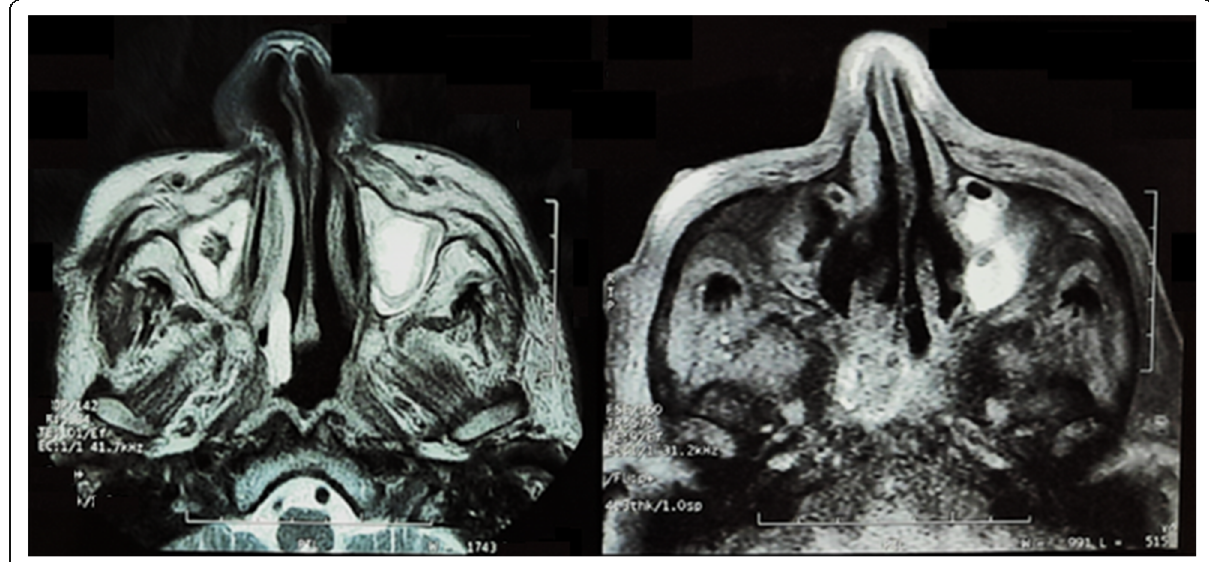
Fig. 2 Axial MRI without contrast along the maxillary sinus showing bilateral sinusitis yet more on the left side with hypo intense margins that goes radiologically with fungal infection with heavy metals deposition and hyper intense center that represents bacterial